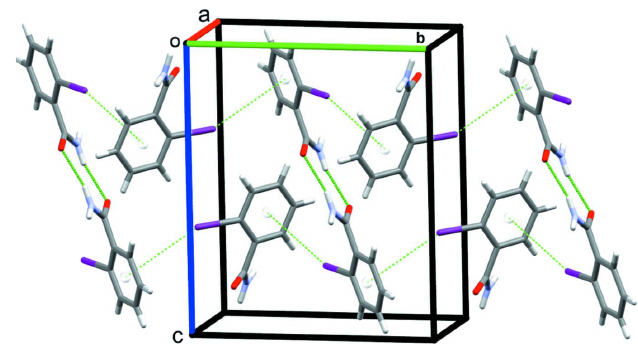
Figure 3 Chains of molecules of (I) along the a -axis direction, showing the dimers and tetramers formed by N—H (cid:2)(cid:2)(cid:2) O hydrogen bonds.